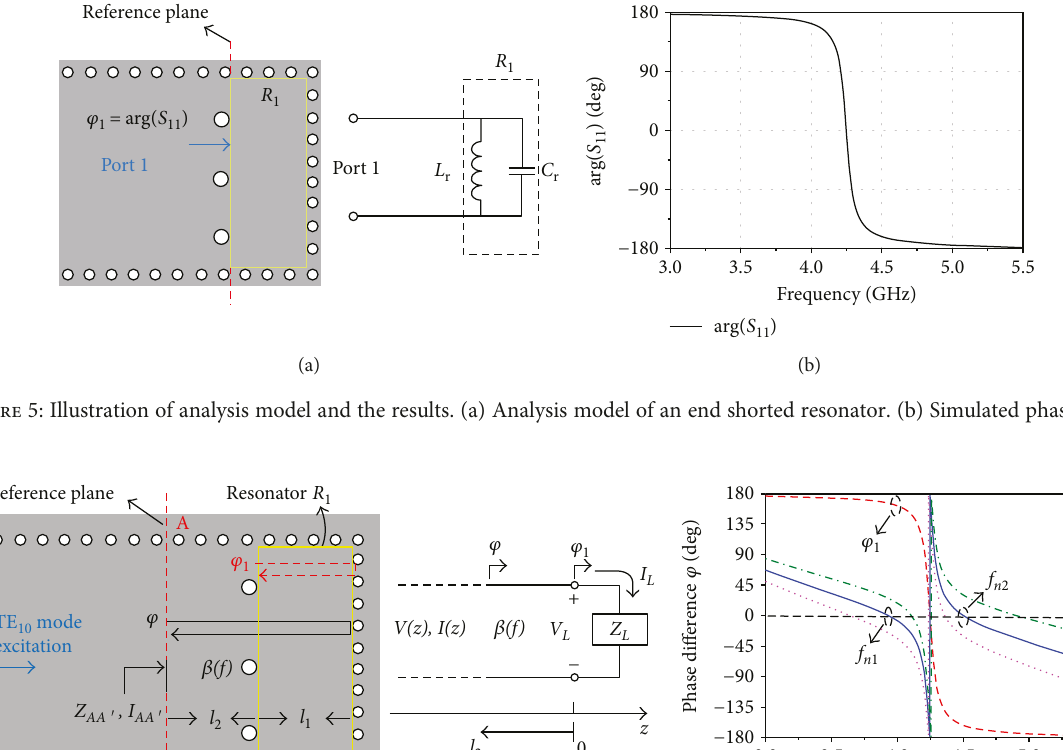
TE mode 10 excitation